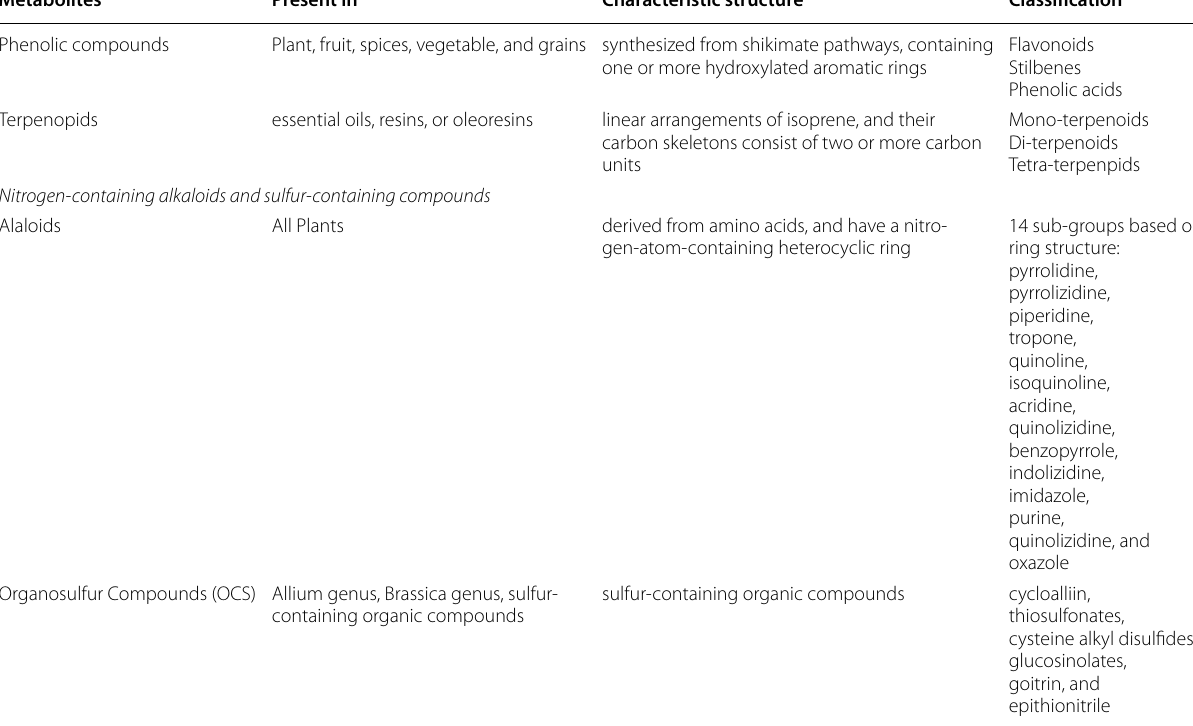
Table 2 Structure-based classification of antitumor